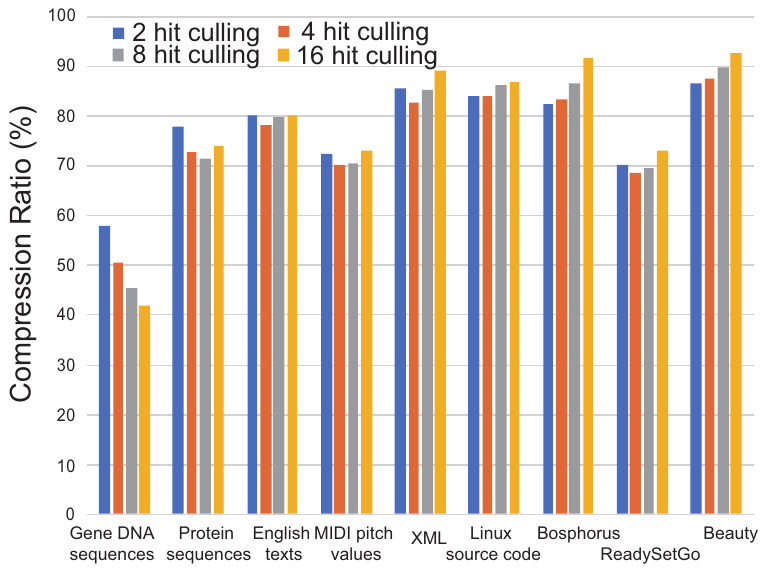
Figure 9. Comparisons of compression ratios of ASE coding with varying the number of hit counting of entropy